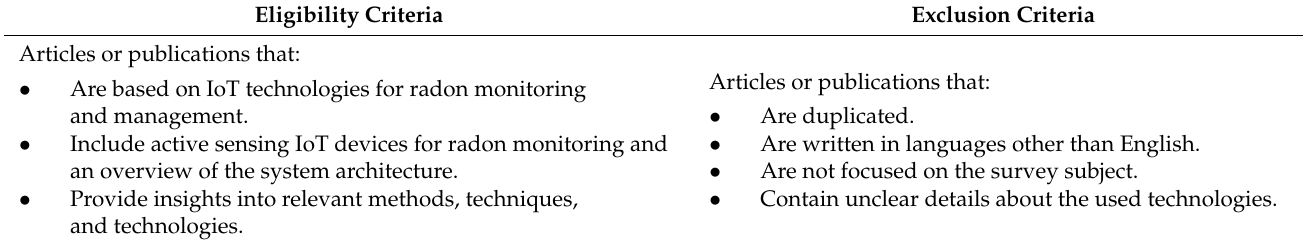
Table 2. Eligibility and exclusion criteria for the